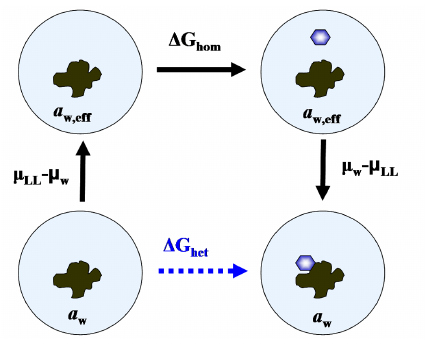
Figure 1. Diagram representing a thermodynamic path, including homogeneous ice nucleation with the same work as heterogeneous